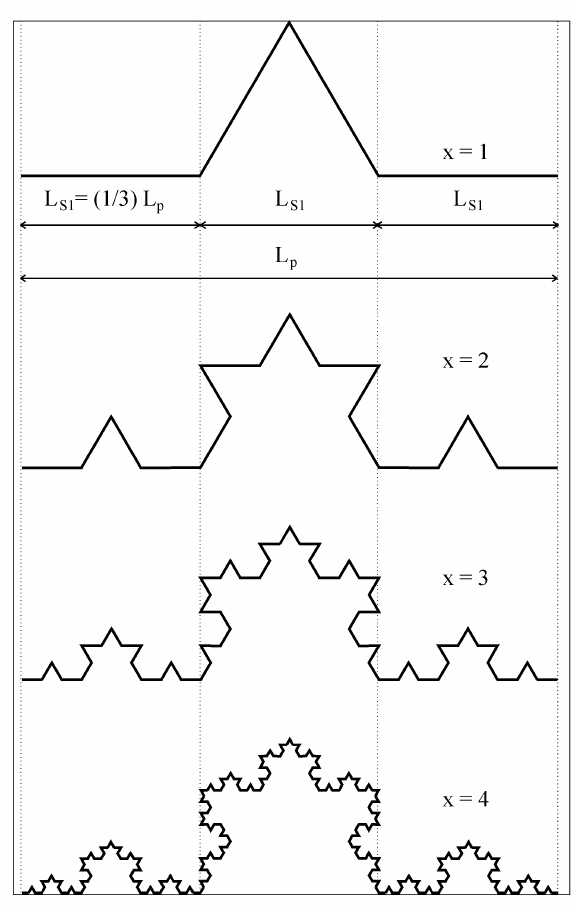
Figure 1. Koch’s line showing different degrees of iteration. The line at the top highlights the shape of the basic picture constituted of four straight